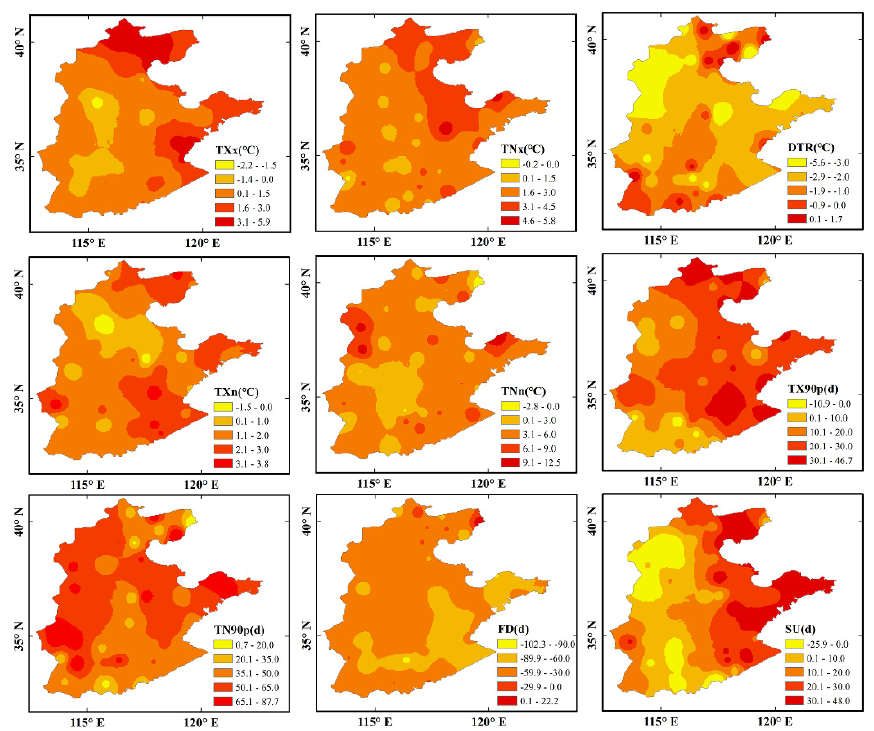
Figure 7. Spatial characteristics of changes in extreme temperature indices in the North China Plain from 2061 to 2100 under the SSP370 scenario.